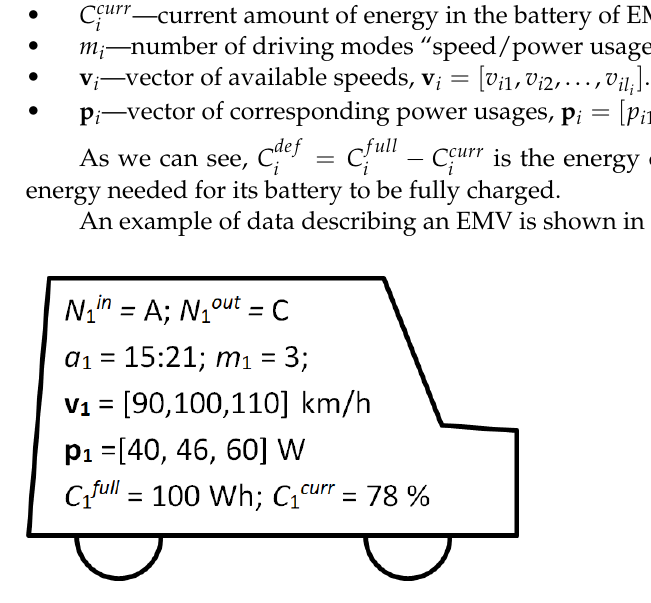
Figure 1. Parameters of an